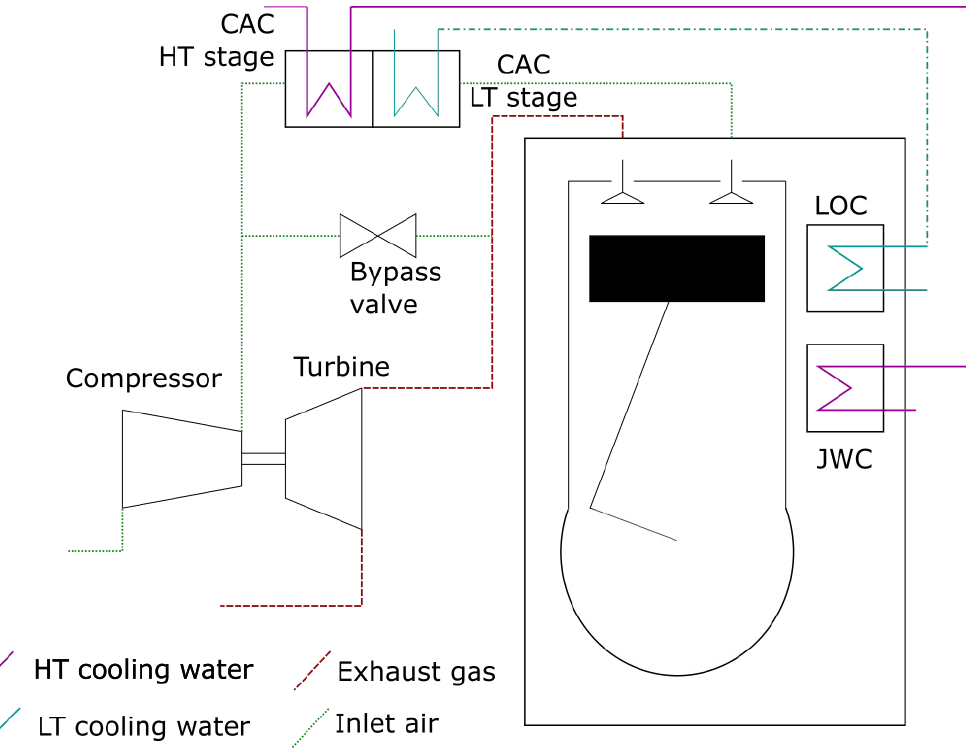
Figure 4. Schematic representation of the Diesel engines and of their connections to the cooling